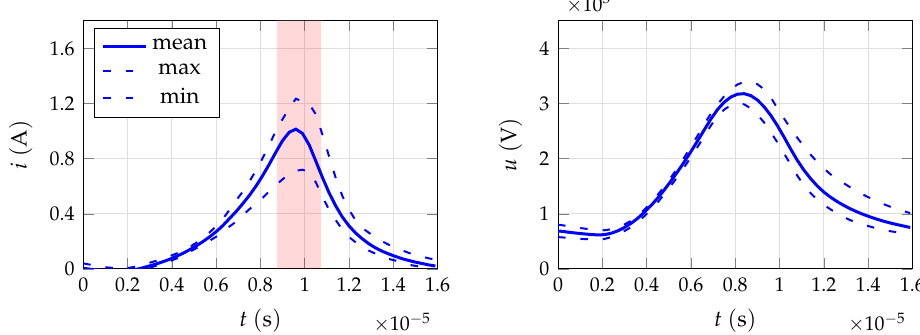
Figure 2. Typical voltage and current traces recorded prior to the power supply at an operating frequency of 60 kHz and a power setting of 100 %. The trigger timeframe at which the experimental setup was triggered is marked in the current plot.